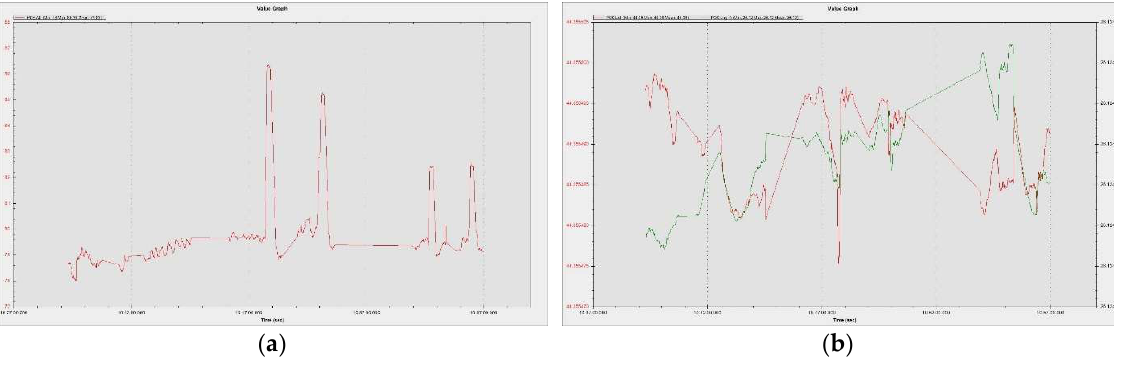
Figure 28. The altitude of the test site . ( a ) Operating altitude of the in situ location; ( b ) Test location.